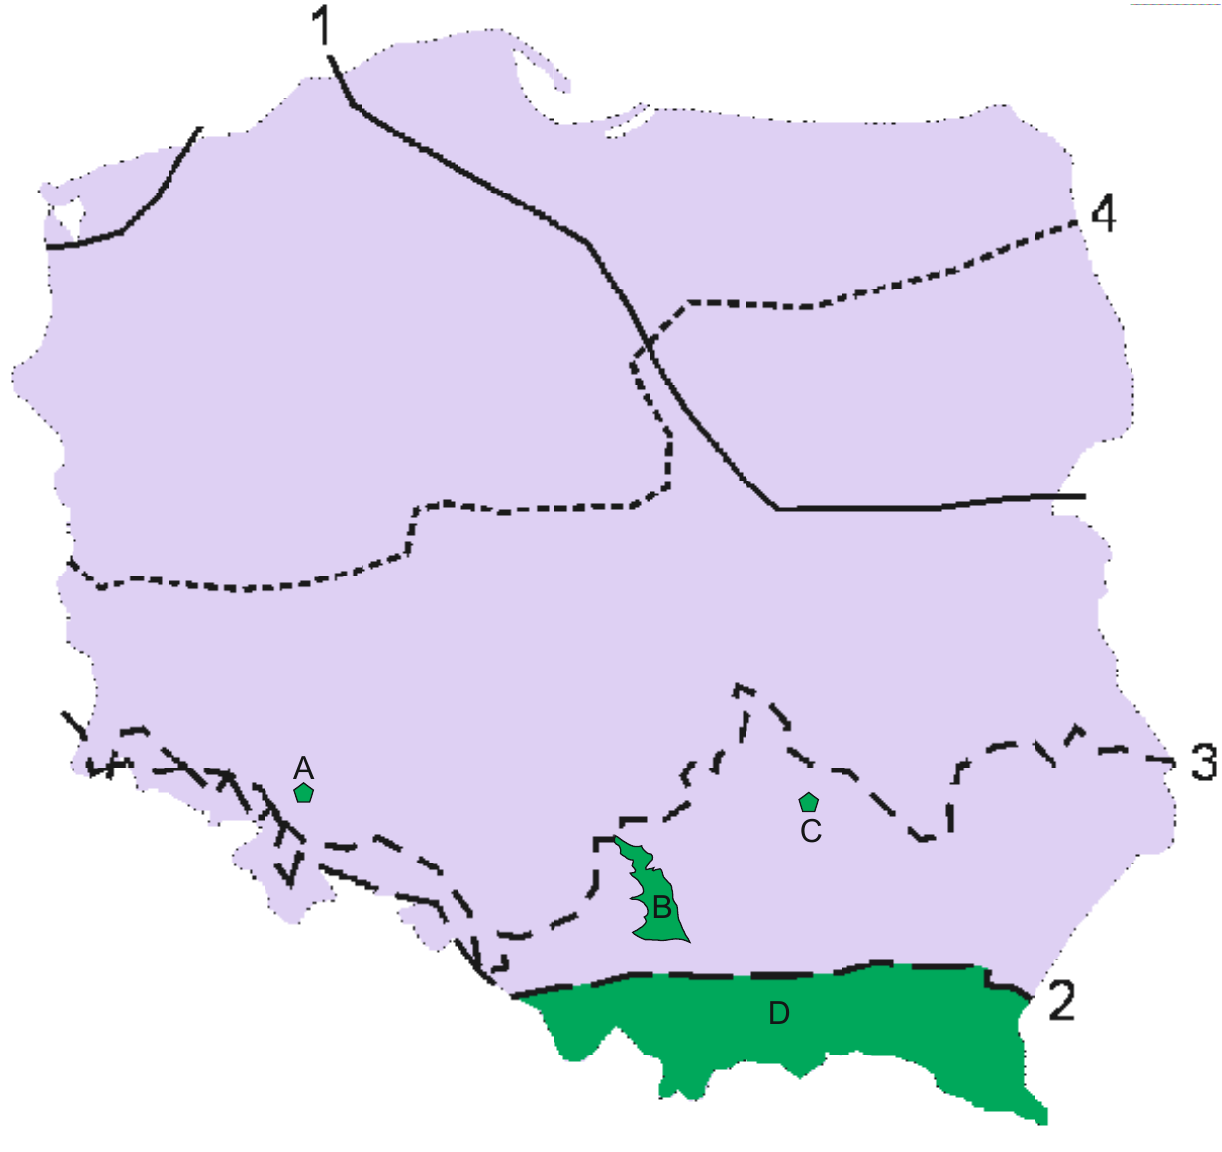
Figure 1. Maximum ranges of glaciations in Poland: 1—Podlaskie glaciation (Günz), 2—South-Polish glaciation (Mindel), 3—Middle Polish glaciation (Riss), 4—North-Polish glaciation (Würm) [1]. The green colour was used to mark areas never affected by the glacier: A—nunatak Ś l ęż a Massif, B—“Jurassic Inland Oasis”, i.e., concave nunatak, C— Ś wi ę tokrzyskie Mountains nunatak, D—area not affected by glaciations in Poland along the cities of Kraków and Przemy ś l.